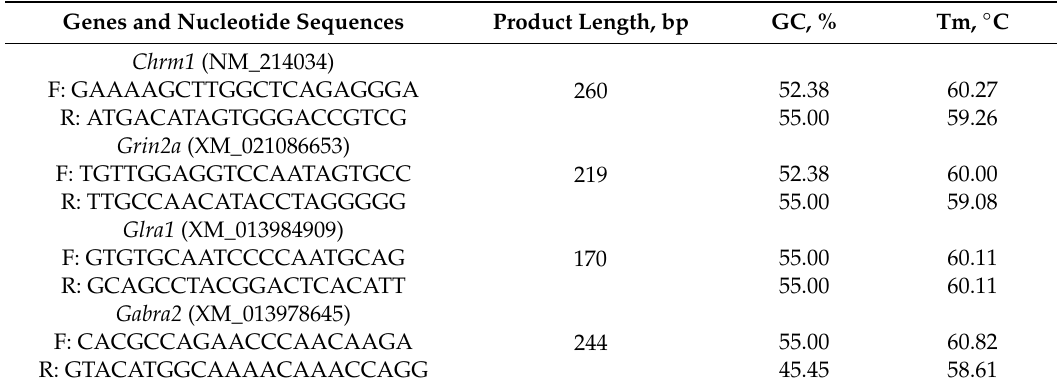
Table 2. Nucleotide sequences of the primers and products of real-time